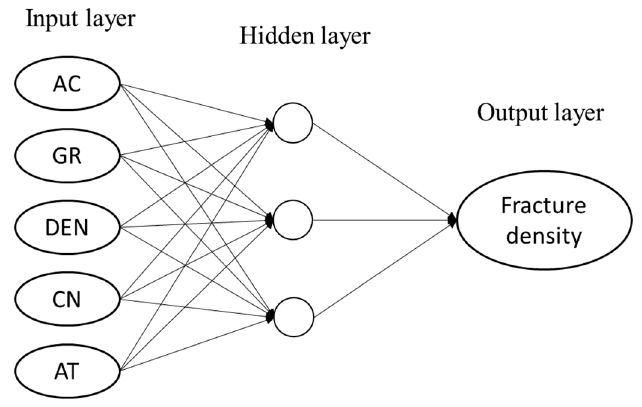
Figure 3. A graphical illustration of the ANN model used in this study.